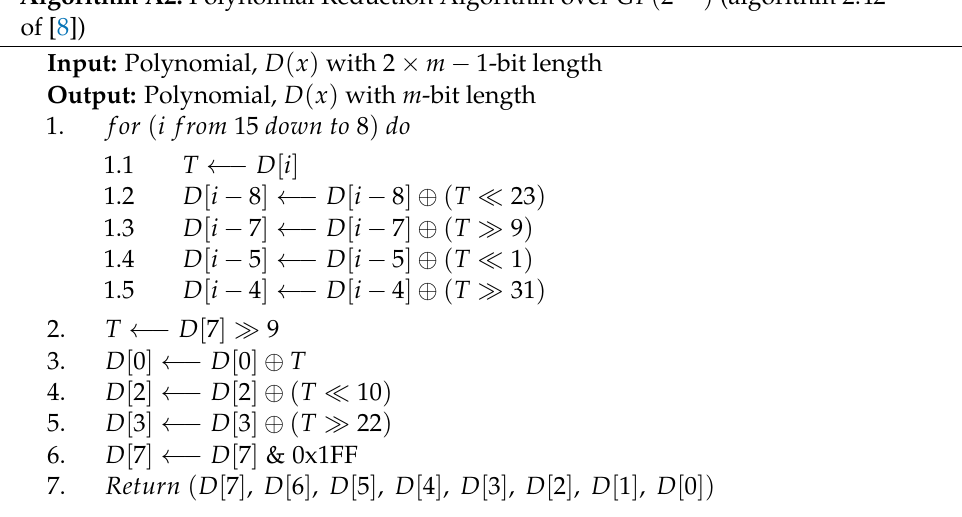
Algorithm A2: Polynomial Reduction Algorithm over GF ( 2 233 ) (algorithm 2.42